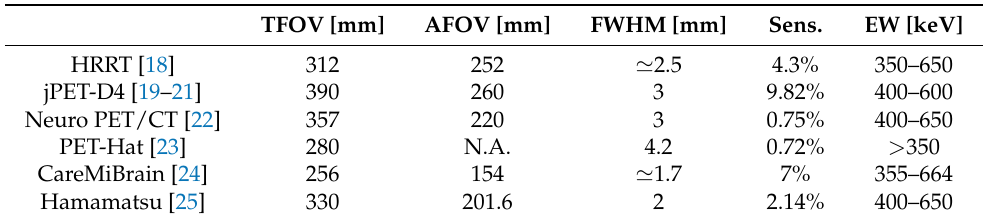
Table 1. Main specifications of brain PET state of the art systems. The Transaxial Field Of View (TFOV) and Axial Field Of View (AFOV) are reported as well as spatial resolution (in terms of Full Width Half Maximum), sensitivity and the energy window (EW) applied.